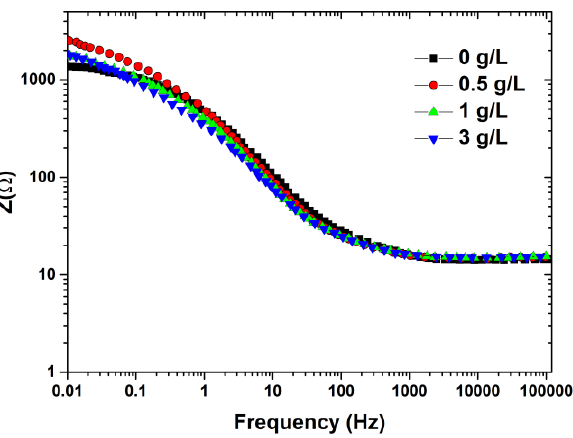
Figure 3. Nyquist plot of the Ni-W alloy and Ni-W/B composite coatings with varying boron con- centrations (0, 0.5, 1, and 3 g/L).